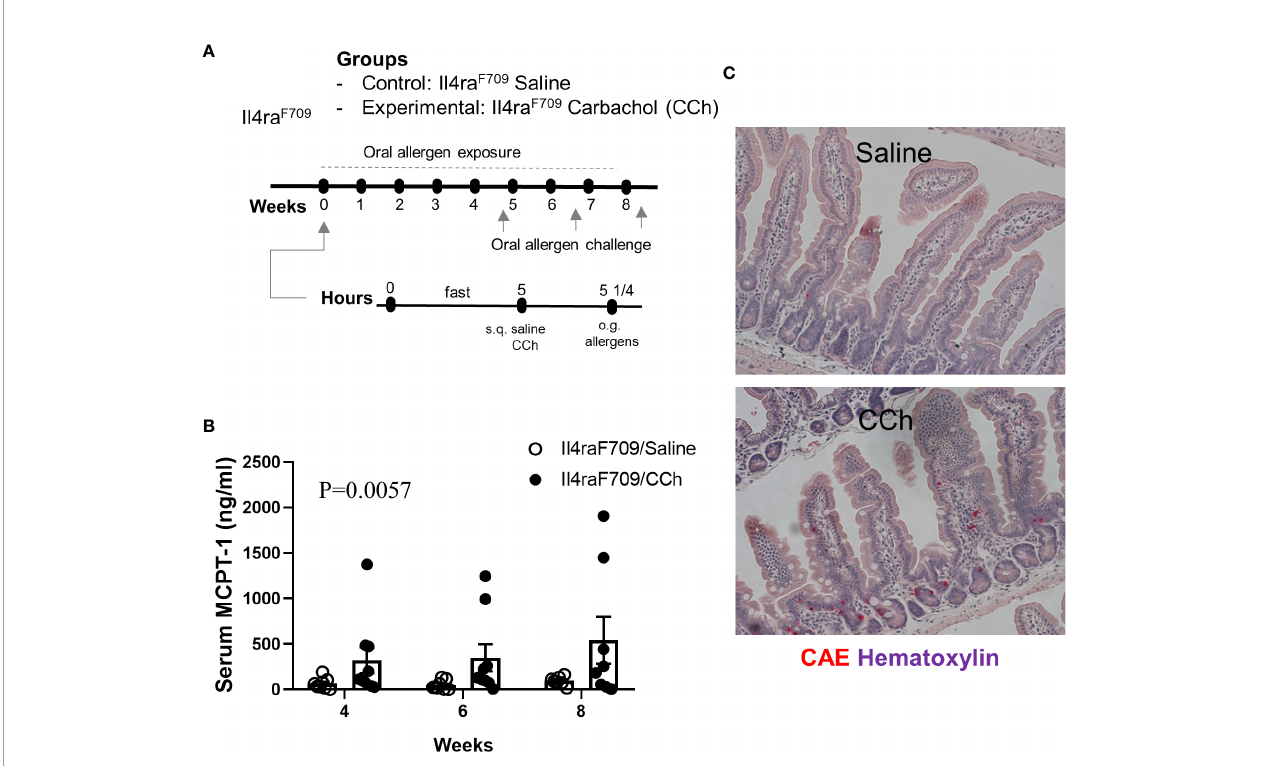
FIGURE 6 | Il4ra F709 mice housed at thermoneutral temperature develop food reactivity when antigen passage is activated. (A) experimental scheme to test the oral reactivity of Il4ra F709 mice at the thermoneutral housing temperature. Clinical reactivity was assessed with (B) the serum MCPT-1 level following oral allergen challenge. Intestinal mast cell number was examined by (C) CAE staining. n=8-9 per